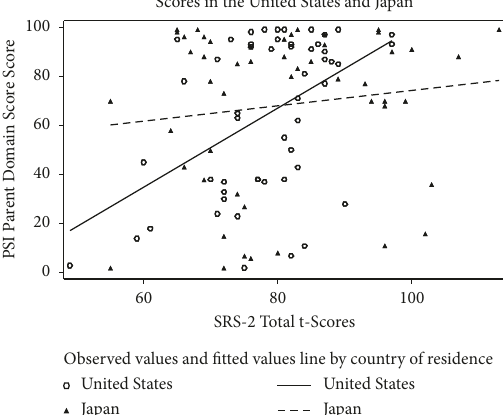
Figure 4: Distribution of the parenting stress index (total, child, and parent domains) and the social responsiveness scale-2 total t-scores by country of residence (U.S. and